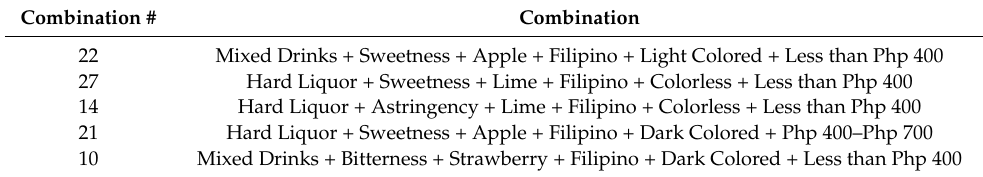
Table 9. Marketing 5P’s